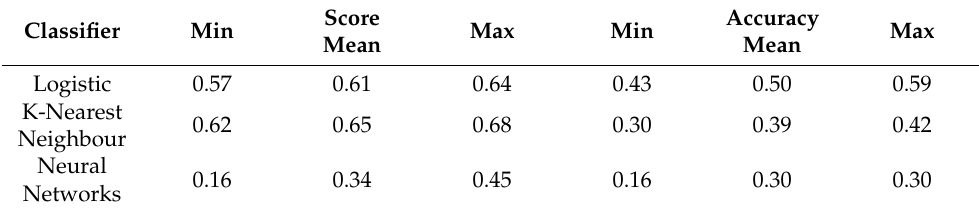
Table 5. The Machine Learning classification